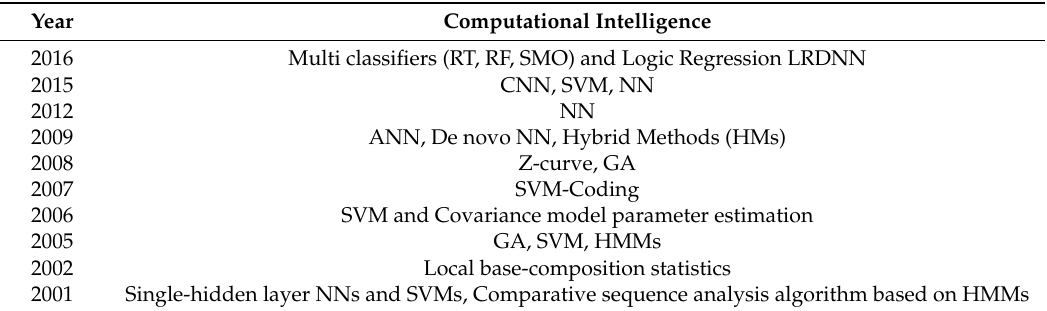
Table 2. A brief summary of CI techniques with respect to classification